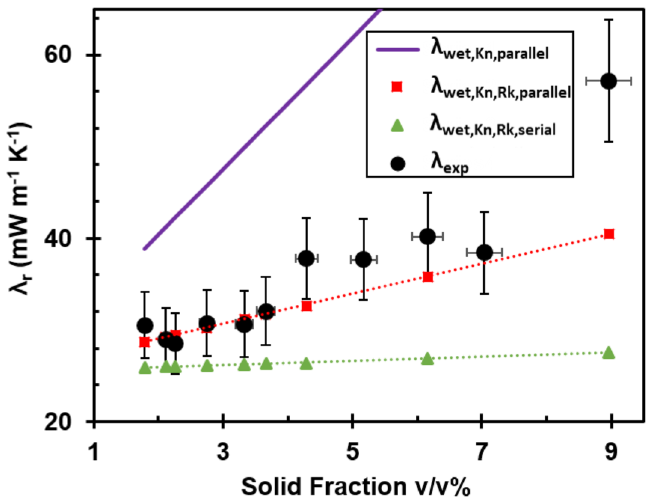
Figure 4. Solid fraction-dependent heat transfer mechanisms in CNC foams. Radial thermal conductivity (λ r ) of CNC foams as a function of CNC solid fraction (v/v%) including the experimental data at 50% RH, the theoretical estimates of λ wet,Kn,parallel including both the uptake of water at 50% RH and the Knudsen effect in the nanopores, and the theoretical estimates of λ wet,Kn,Rk,parallel and λ wet,Kn,Rk,serial additionally including the